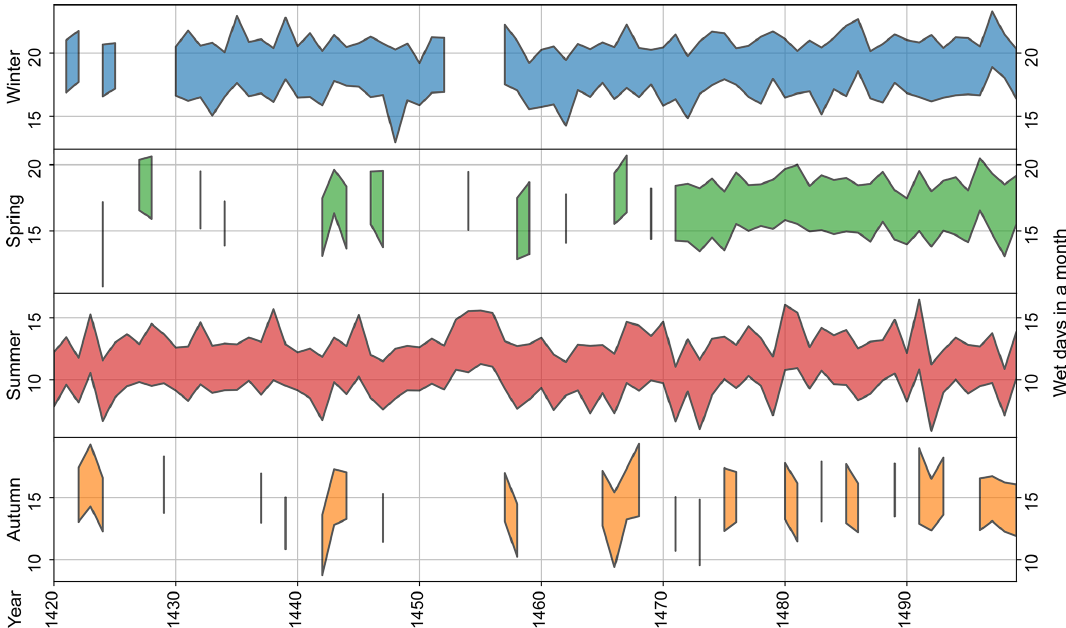
Figure 8. Seasonal mean wet days in a month in the Burgundian Low Countries from 1420 to 1499CE. Colored areas show mean wet days ± 1 standard deviation averaged over all members of the ModE-Sim ensemble. They are reconstructed from posterior probability distributions after assimilating regional information from historical documents.